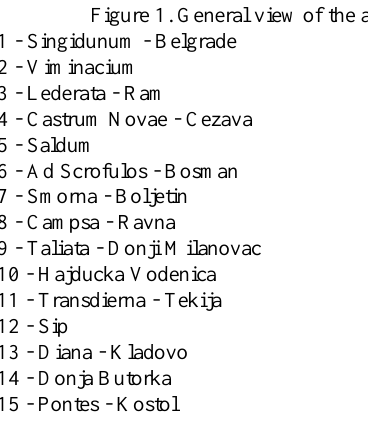
Figure 1. General view of the analyzed